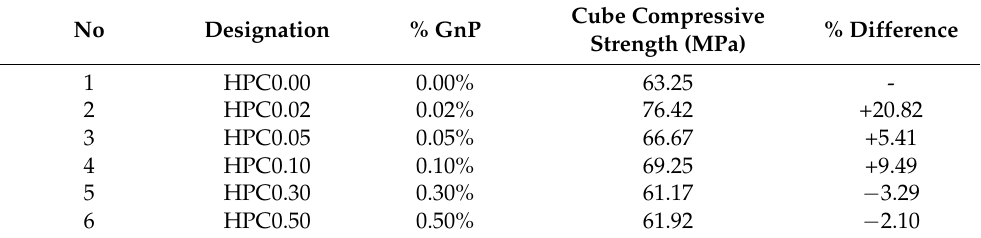
Figure 5. Experimental HPC-GnP specimens prepared for tests: ( a ) the pullout; ( b ) compressive strength. Table 6. Compressive strength of HPC with different content of GnP.